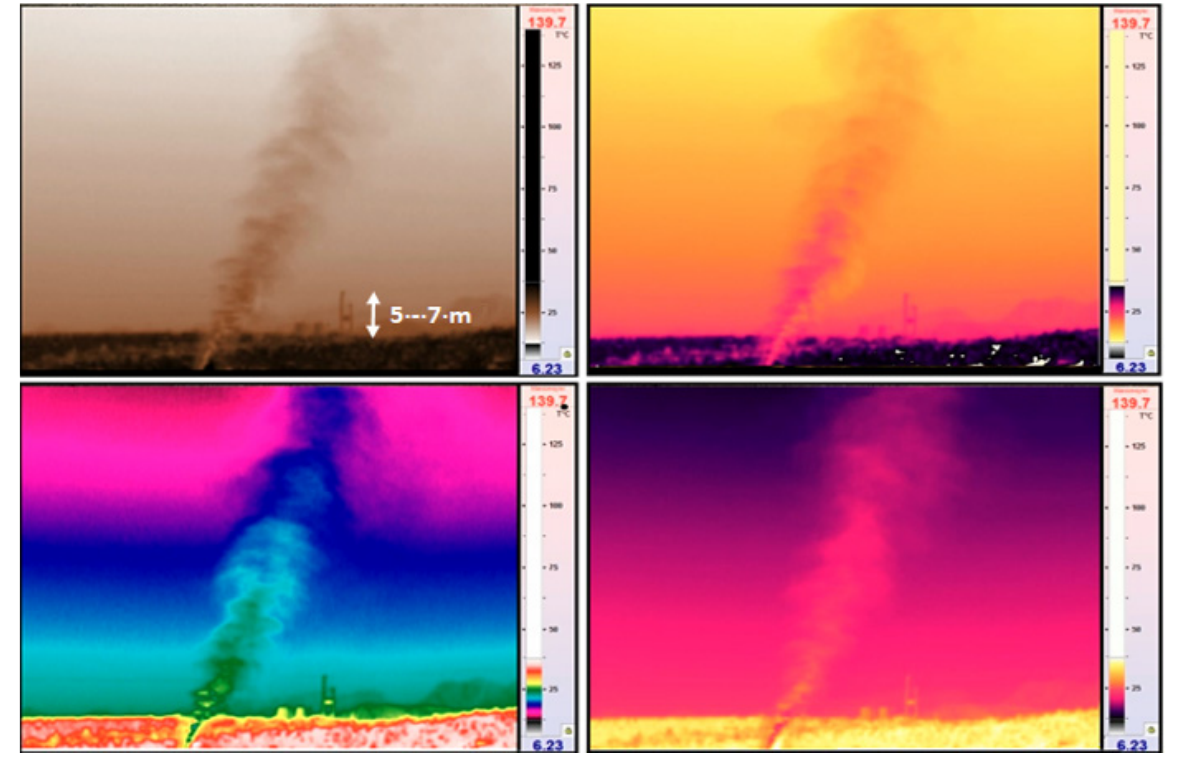
Figure 6. Jet form according to thermograph IRTIS-2000C on different visualization regimes, 17 March 2021.